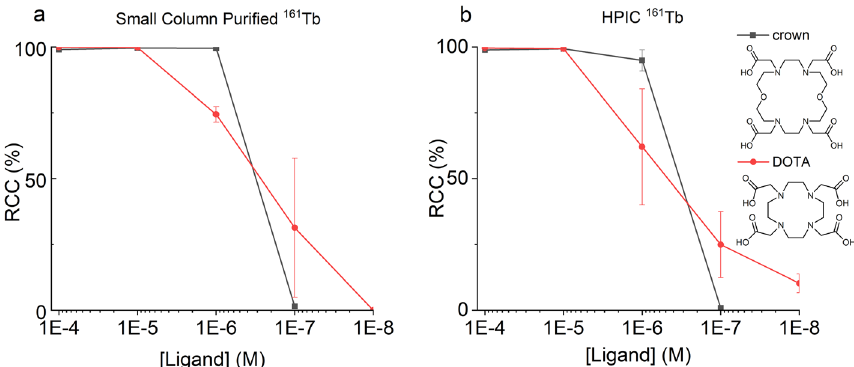
Fig. 6 Labelling comparison between small column ( a ) and HPIC ( b ) purified 161 Tb (100 kBq for each reaction) with crown (room temperature, 30 min), and DOTA (85 °C, 30 min). RCC